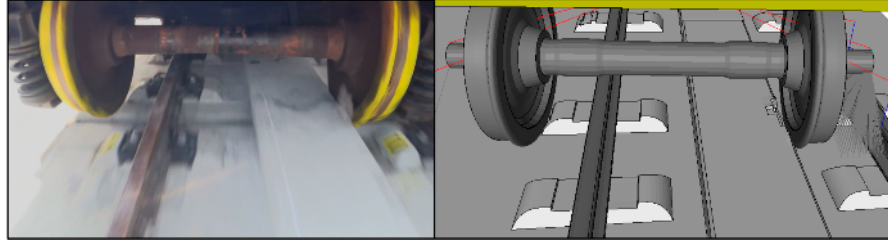
Figure 21. Collision with the DCP.